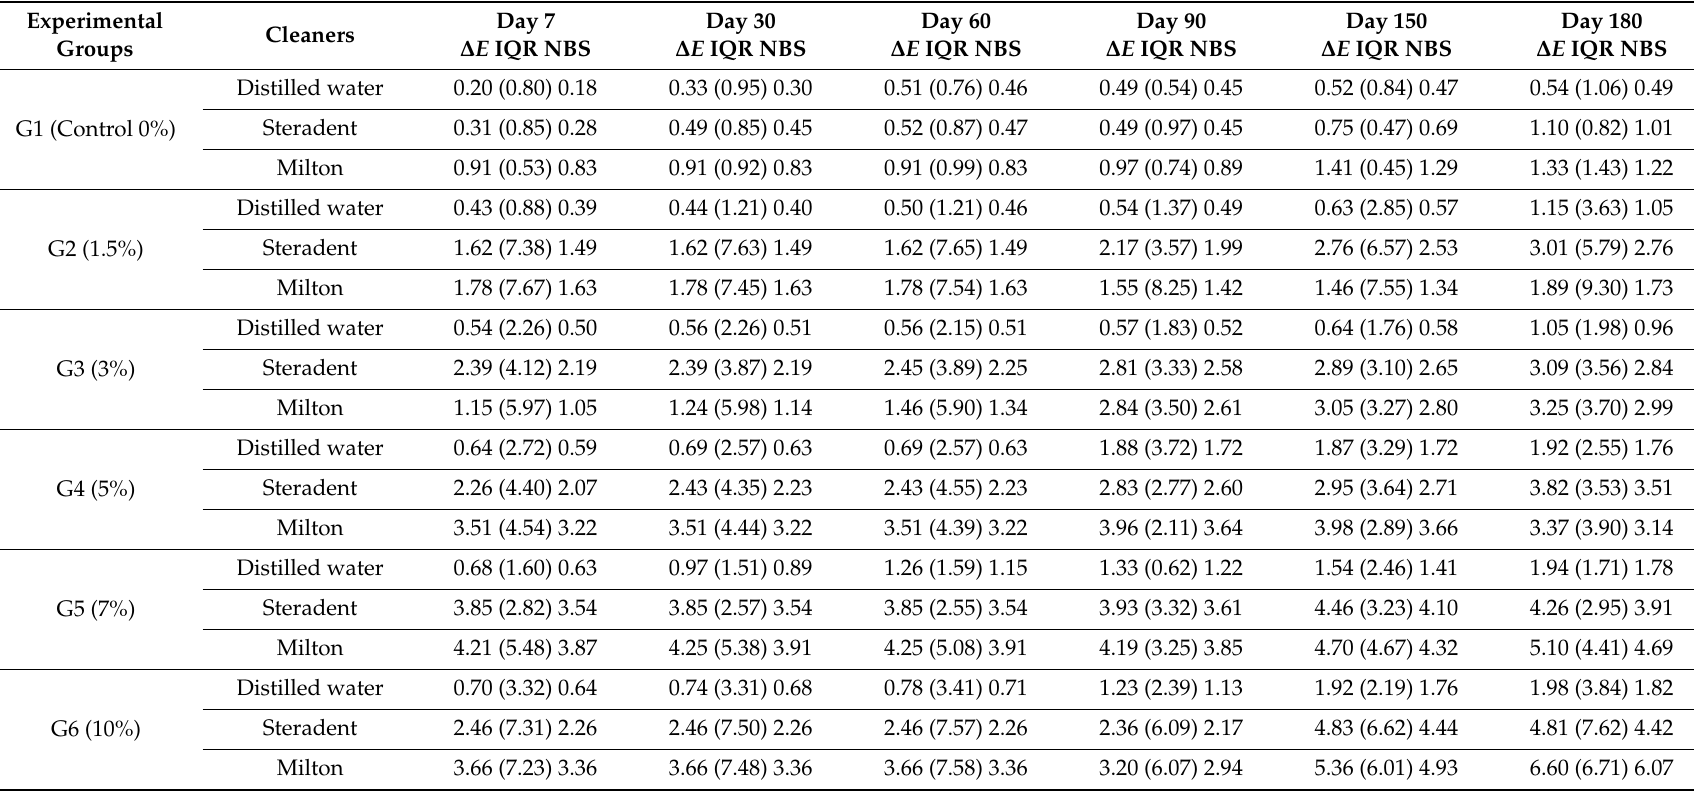
Table 4. Median values and Interquartile Range (IQR) of colour change and National Bureau of Standards (NBS) unit for specimens (control 0 wt.%, 1.5 wt.%, 3 wt.%, 5 wt.%, 7 wt.% and 10 wt.% of zirconia) immersed in distilled water, Steradent and Milton over time.